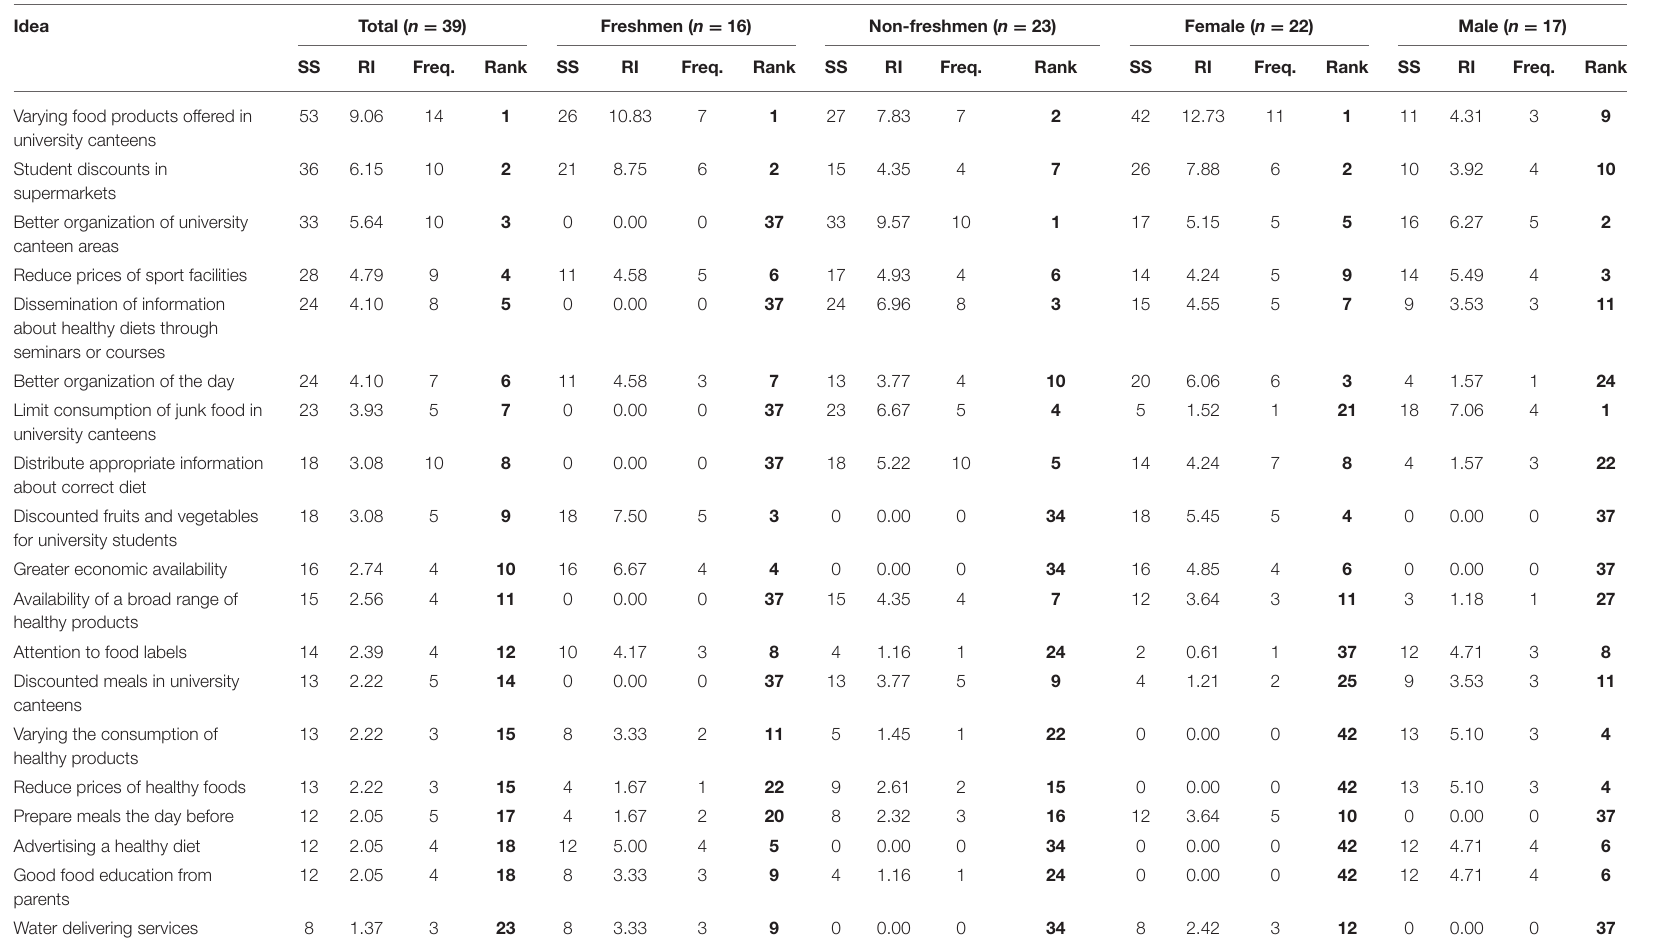
TABLE 5 | Aggregated results across the 7 groups for strategies to maintain a healthy